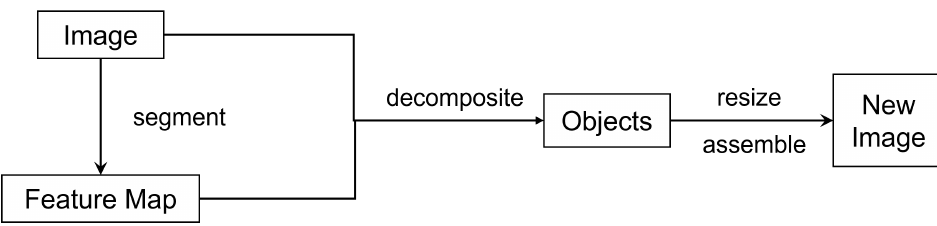
Figure 4. Flowchart for image retargeting.